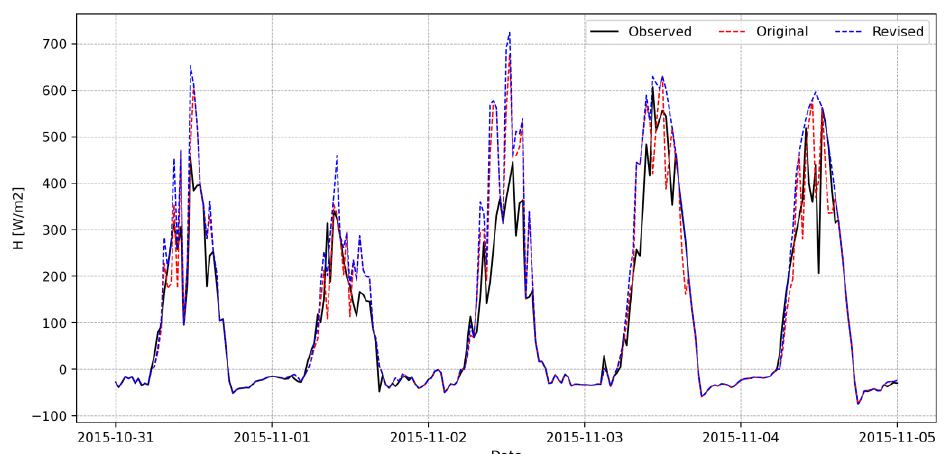
Figure 3. Variations in the observed and simulated sensible heat flux by the original and the revised parameterization at 30 min temporal resolution over five days at the AU-GWW site.